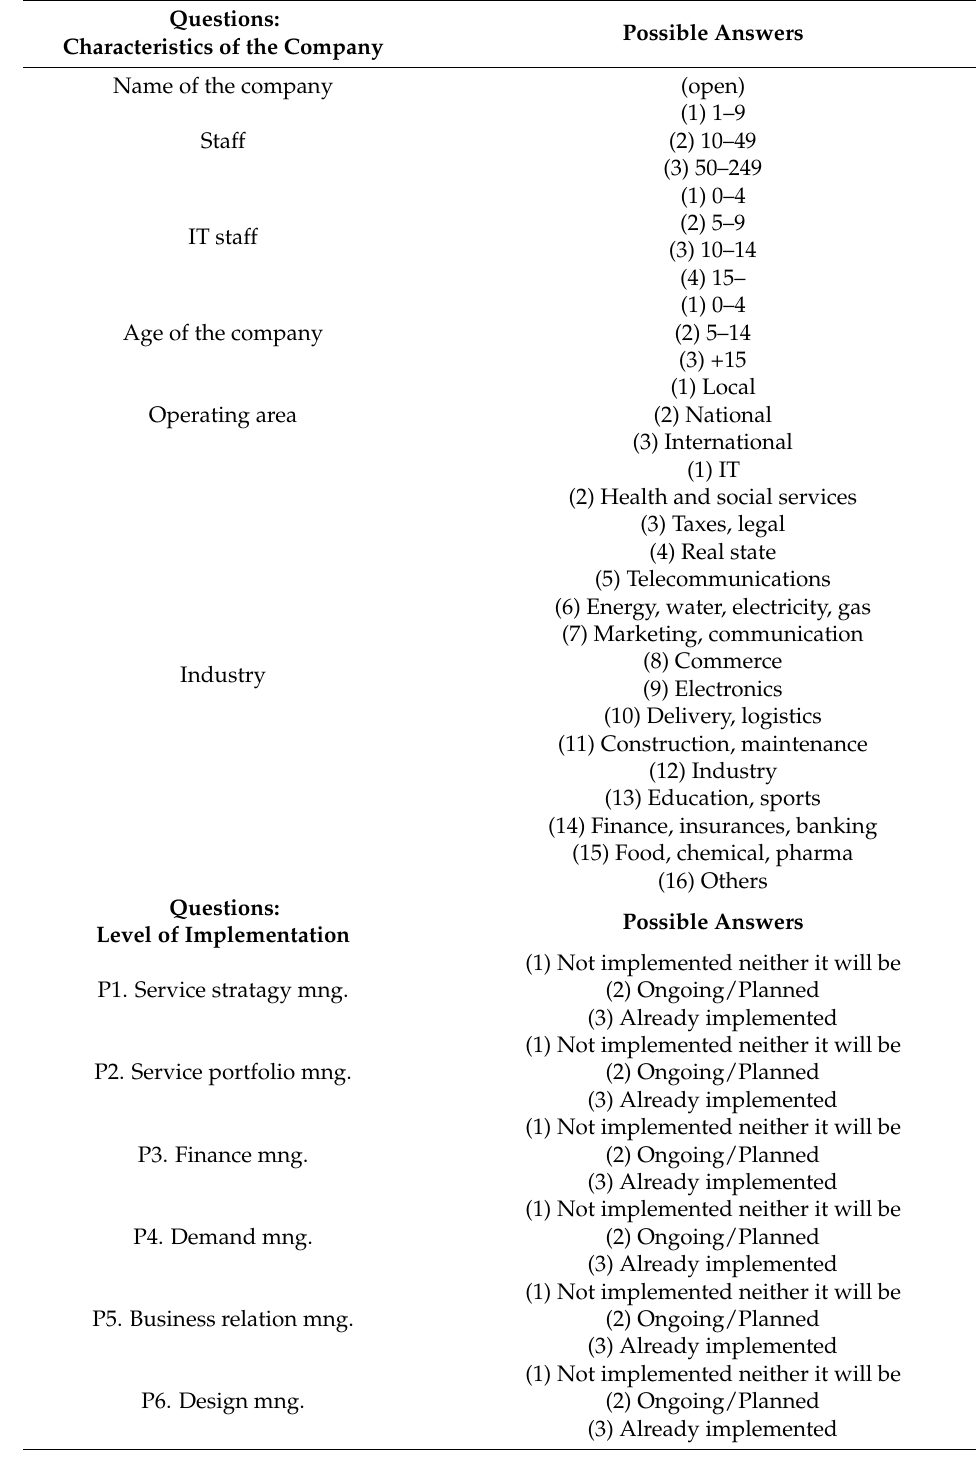
Table A1. Questions used to get the data of the